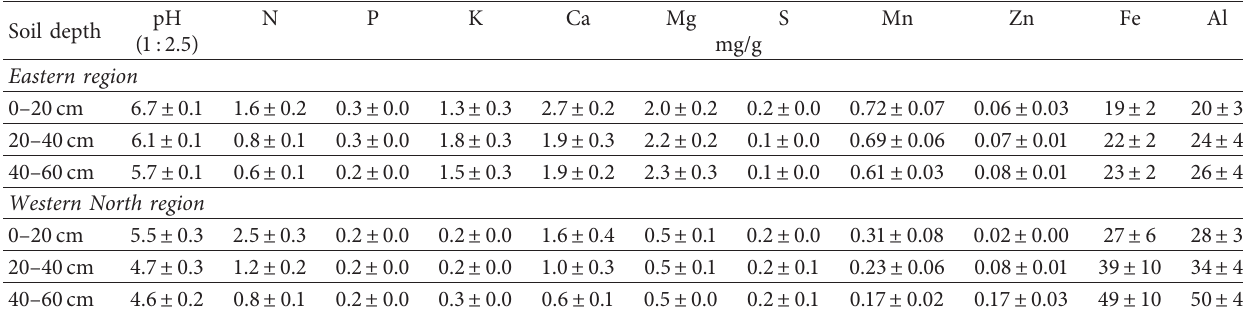
Table 3: Soil chemical properties ( ± standard error) at different depths under cocoa ecosystems in the Eastern and Western North regions of